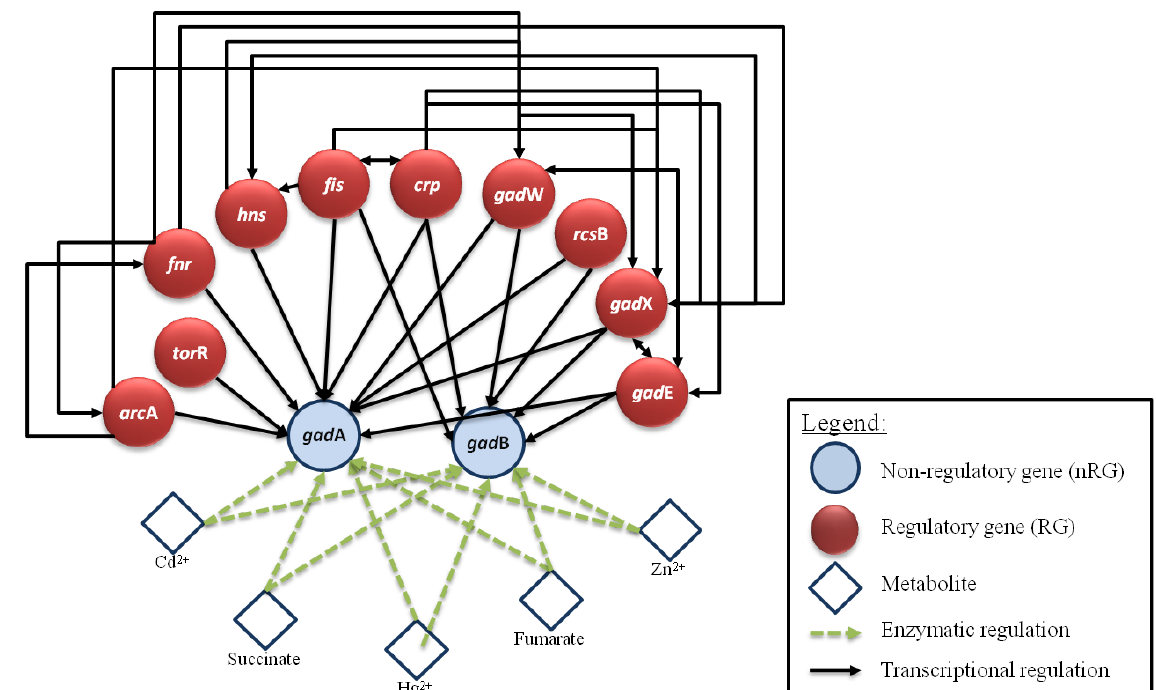
Figure 6: Examples of co-regulation affecting the “Glutamate Metabolism”. Although with sim- ilar metabolic functions, the transcriptional control of the two glutamate decarboxylases coded by gad A and gad B genes is different, e.g. the TorR transcriptional regulator affects the expres- sion of gad A, but not gad B. The enzymatic regulation of the two isoenzymes is identical, involving the inhibition of their activity via the binding of divalent cations (Zn 2+ , Hg 2+ and Cd 2+ ) and dicarboxylic acids (succinate and